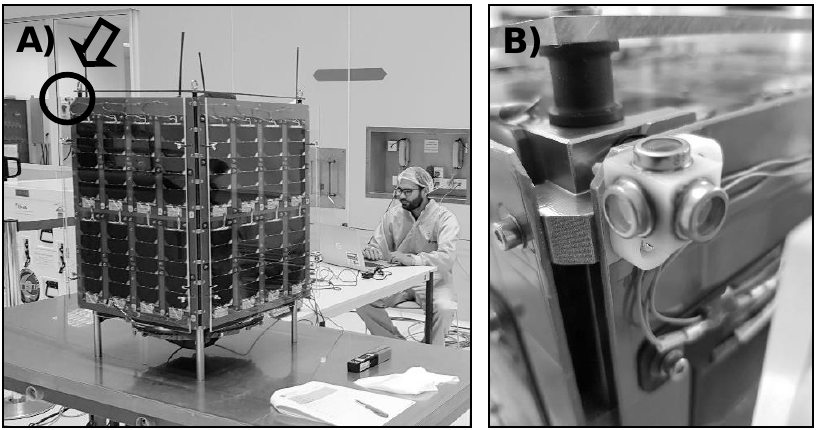
Figure 1. ( A ) UPMSat-2 at satellite at the Centre Spatial Guyanais of CNES (Kourou, French Guiana). February 2020. ( B ) SS1 sun sensor set, composed of three photodiodes. Pictures courtesy of Instituto